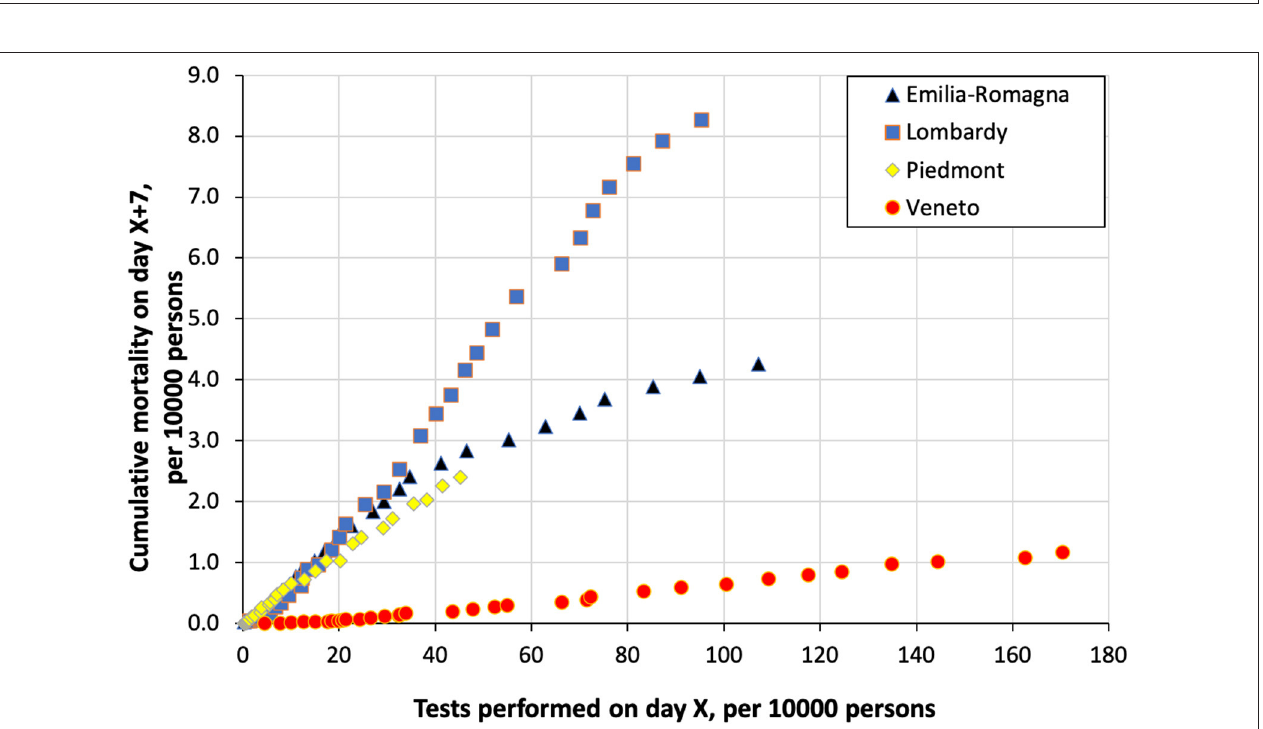
FIGURE 2 | Cumulative COVID-19 mortality in four regions in northern Italy from March 2 through April 3 as a function of the cumulative number of COVID tests performed 7 days before, i.e., from February 24 through March 27.